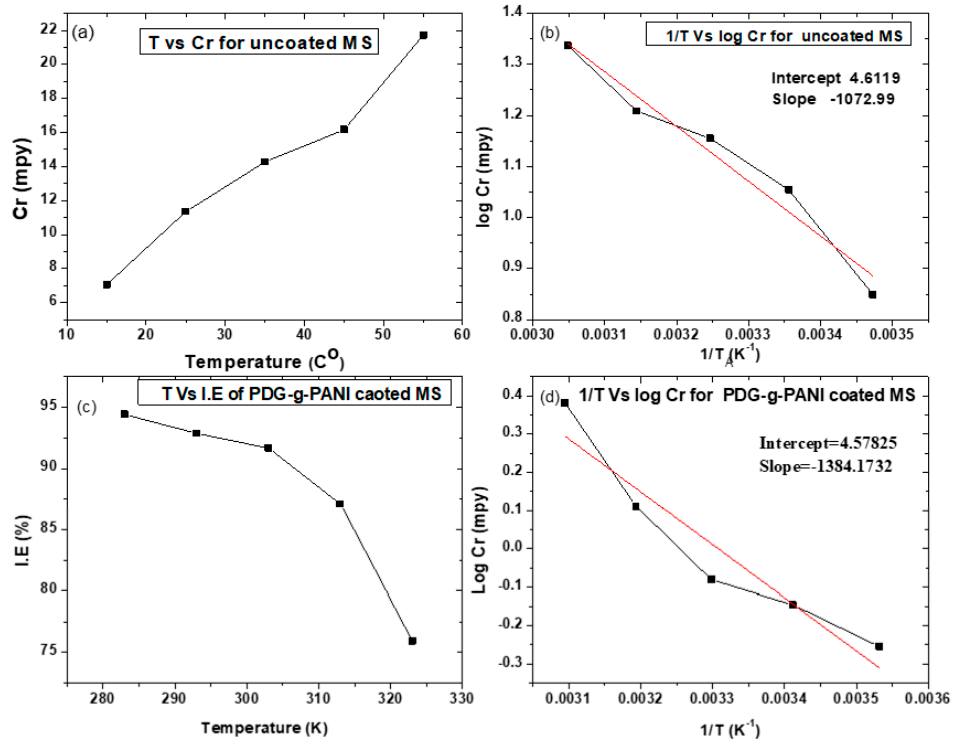
Figure 11. ( b , d ) Arrhenius plots of uncoated and PDG-g-PANI-coated MS corrosion in 3.5% NaCl solution, ( a ) temperature vs. corrosion rate graph for uncoated MS, ( c ) temperature vs. inhibition efficiency of PDG-g-PANI-coated MS. Table 4. Calculated activation energies of uncoated MS and PDG-g-PANI-coated